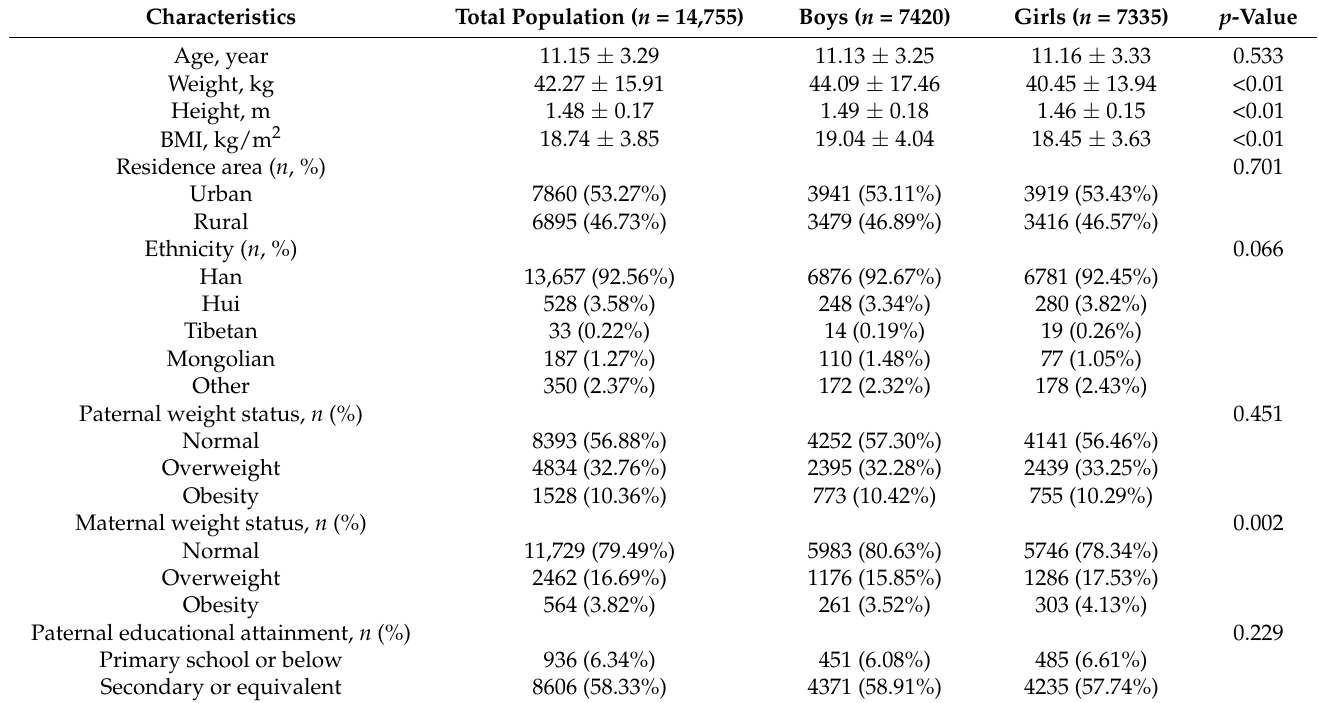
Table 1. Baseline characteristic of included